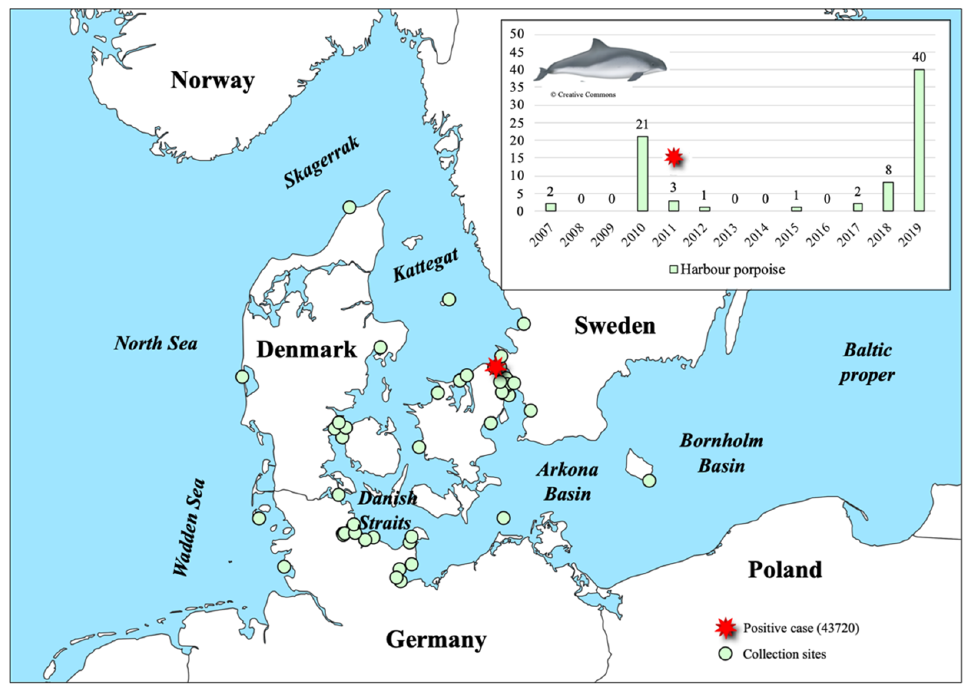
Figure 1. Map and histogram illustrating collection sites (green dots) and distribution of 77 harbour porpoises screened per year between 2007 and 2019. The red star indicates the collection site of the Phocoena pestivirus (PhoPeV) ‐ positive harbour porpoise (ID: 43720 and collection date: 4 February 2011).